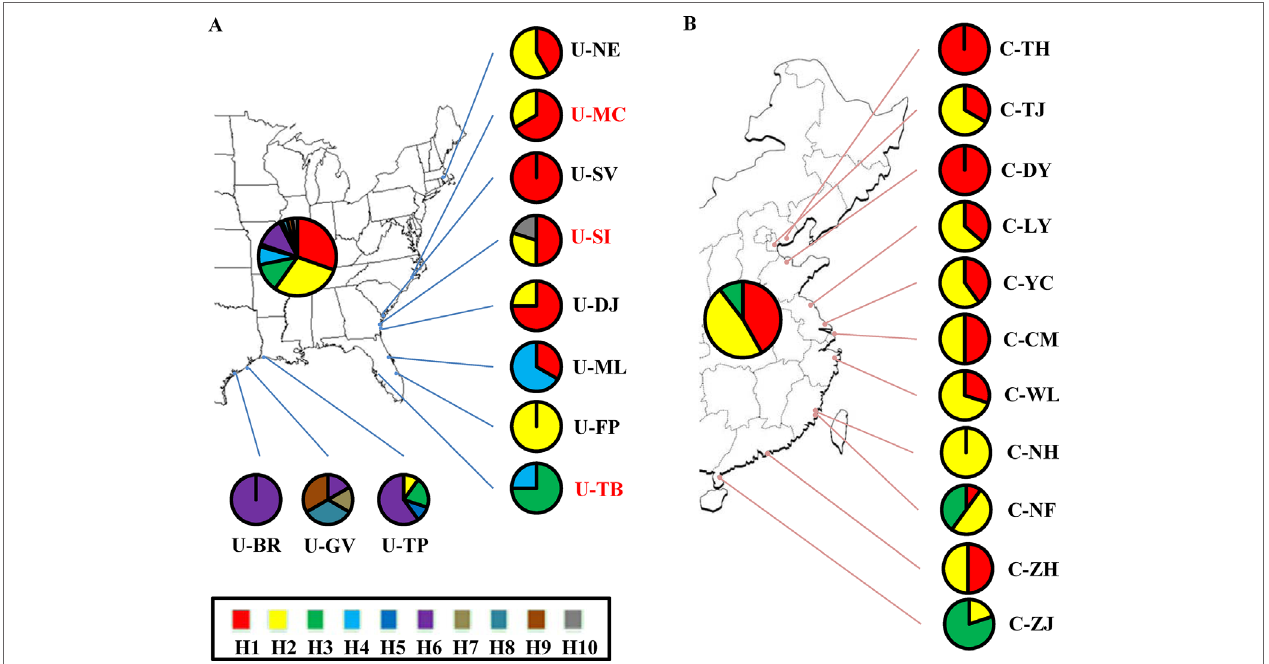
FIGUre 2 | Geographic distribution of 10 chloroplast haplotypes detected in S. alterniflora . Pie charts represent the proportion and distribution of haplotypes across (a) native US and (B) invasive China ranges. Population and haplotype names in the map are the same as those in Table 1 and Supplementary Figure 2 .